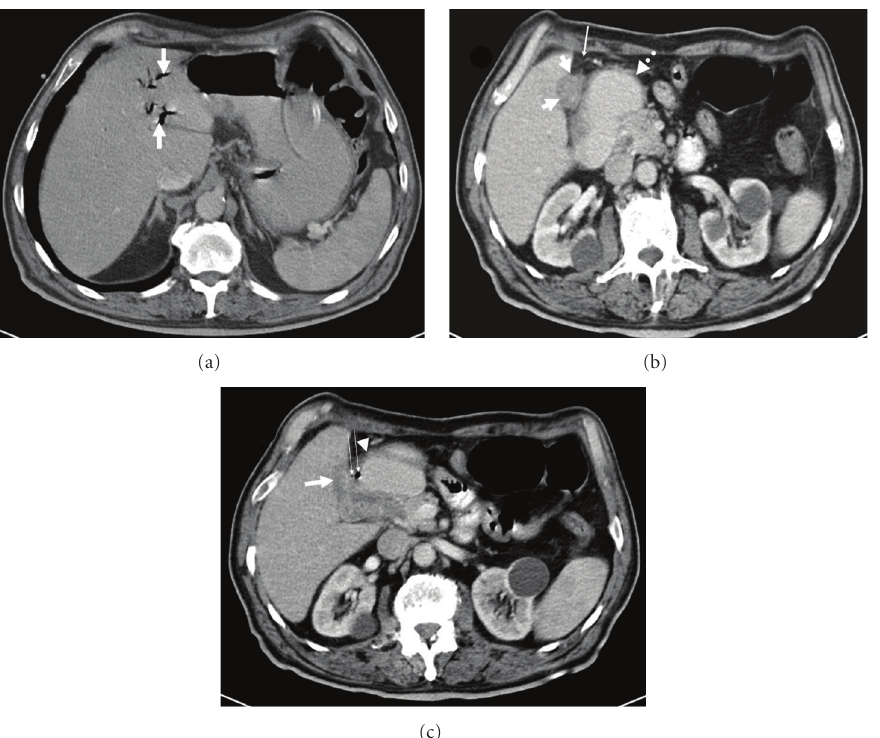
Figure 2: (a) On nonenhanced axial CT image, air in the biliary tree of the left lobe is illustrated. A nasogastric tube within dilated stomach is noted as well. (b) On post-contrast portal venous phase, axial CT image, a collapsed GB (short arrows) having irregularly thickened, heterogeneously hypoechoic, and slightly enhancing wall accompanied with pericholecystic stranding (long arrow) and the dilatation of first and second portions of duodenum (dotted arrow) are illustrated. (c) On post-contrast portal venous phase axial CT image, irregularly thickened and heterogenous GB wall (short arrow) is imperceptible from the medial duodenal wall (arrowhead) and at this area, two air bubbles are identified (long arrows) indicating a cholecystoduodenal fistula.